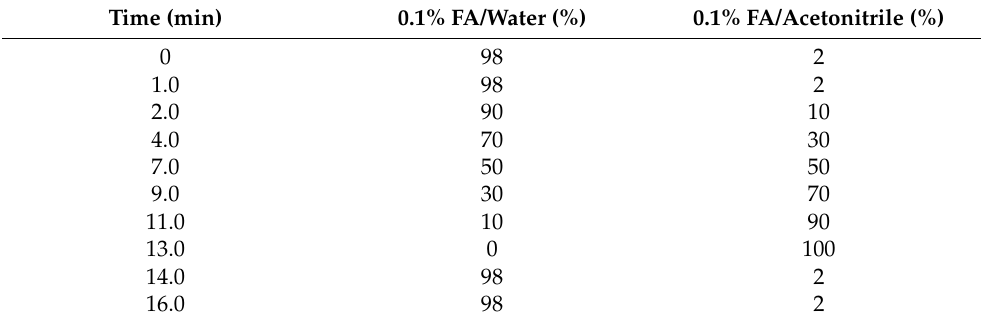
Table 1. The analysis condition of chlorogenic acid, quercetin, and kaempferol. FA—formic acid. Time (min) 0.1% FA/Water (%) 0.1% FA/Acetonitrile (%) 0